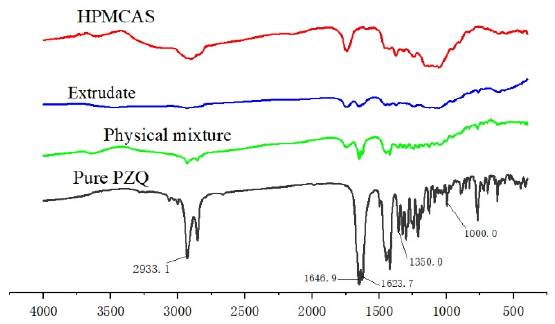
Figure 4. FTIR spectra of pure PZQ, a physical mixture, extrudate and HPMCAS.